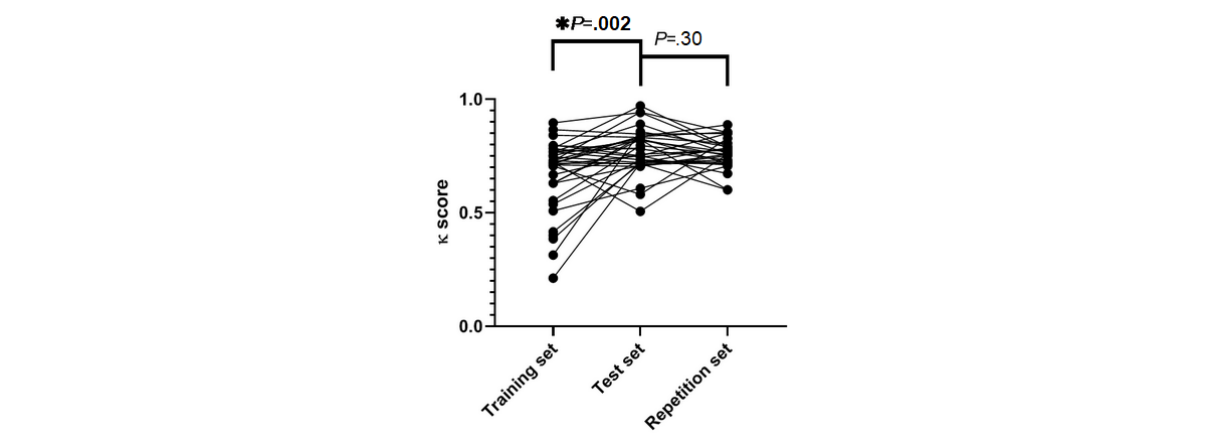
Figure 3. Progress of κ scores per participant during the e-Learning module.